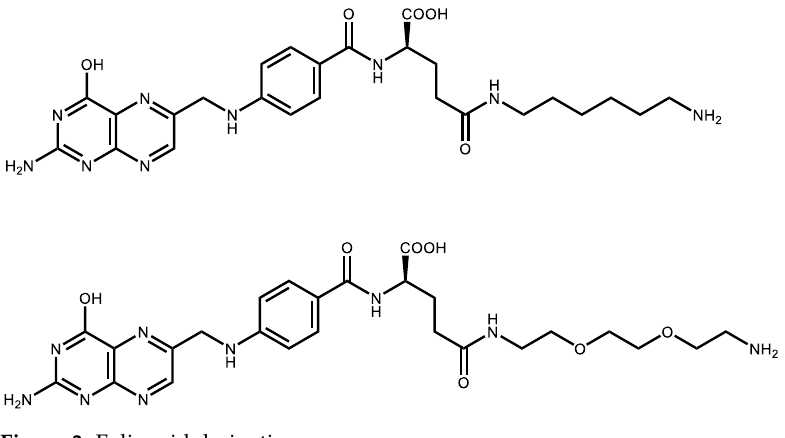
Figure 3. Folic acid derivatives.